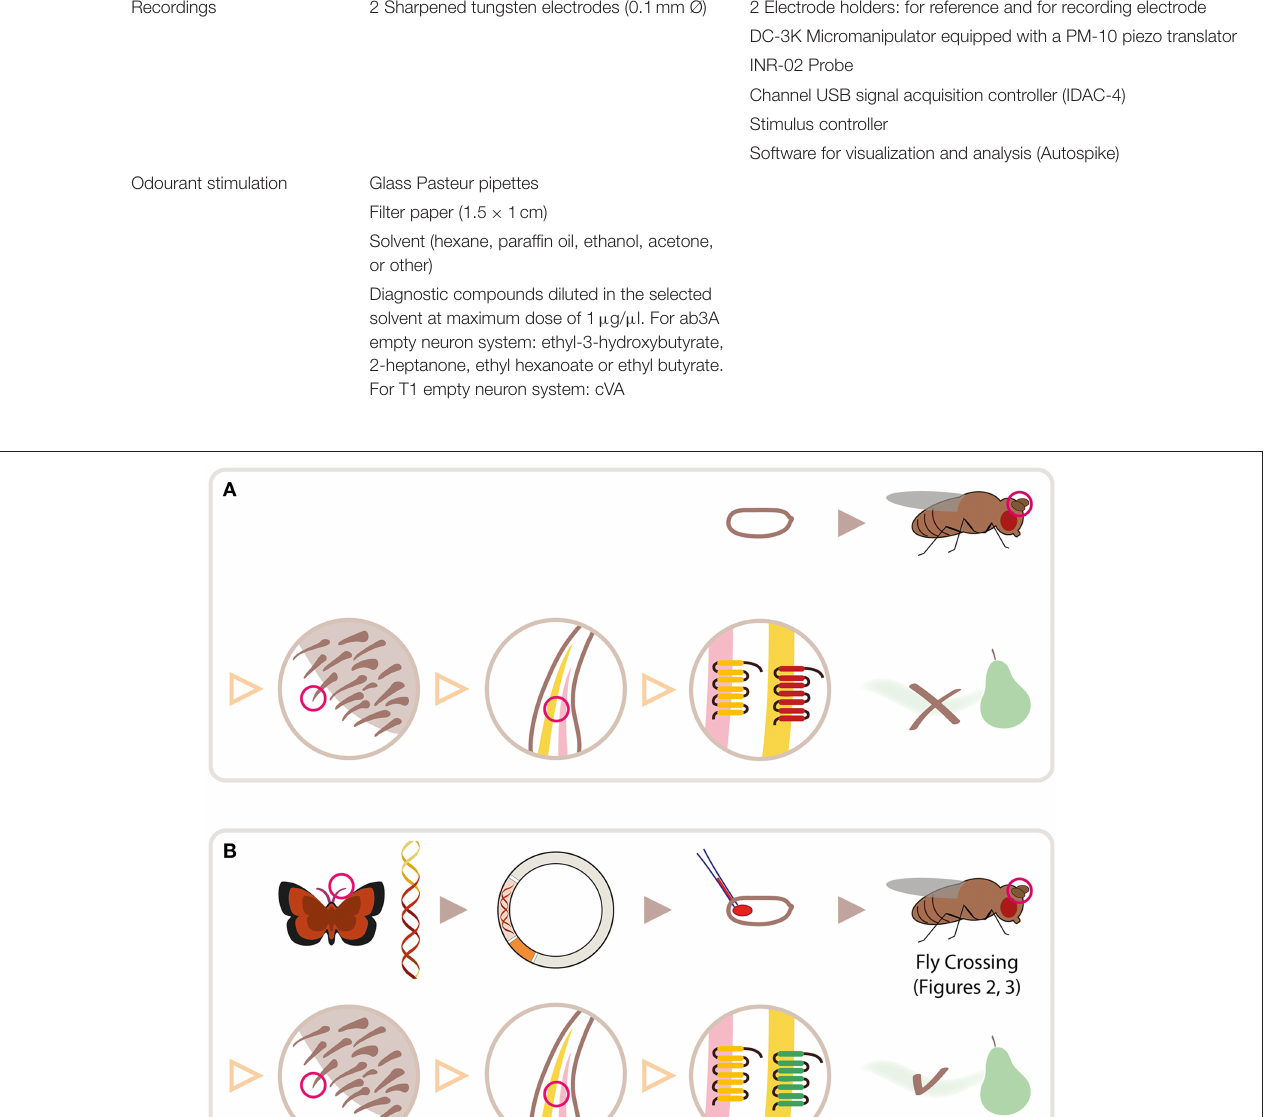
Frontiers in Ecology and Evolution |